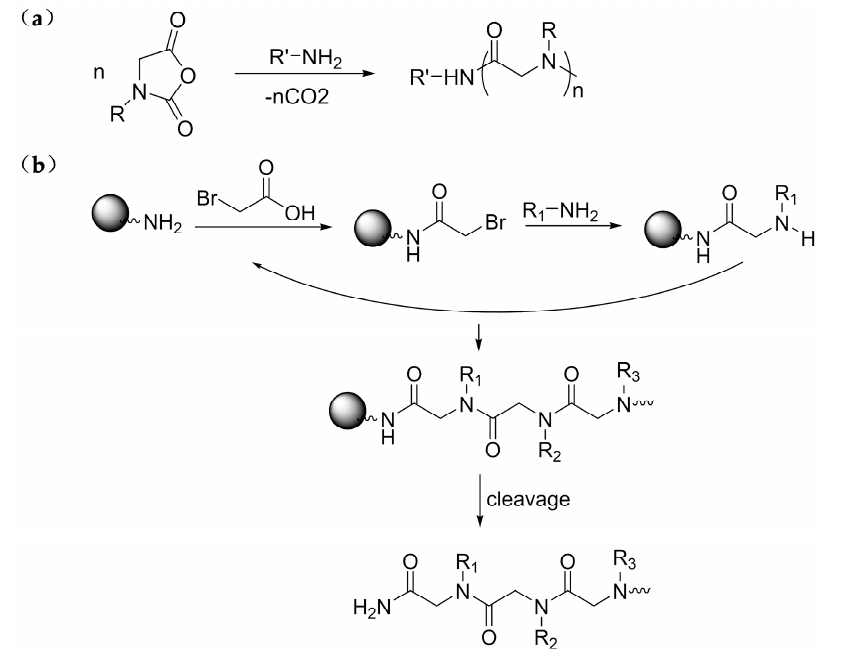
Figure 2. Synthesis of polypeptoid by ( a ) ring-opening polymerization of R-NCA initiated by primary amine and ( b ) solid-phase submonomer synthesis method.